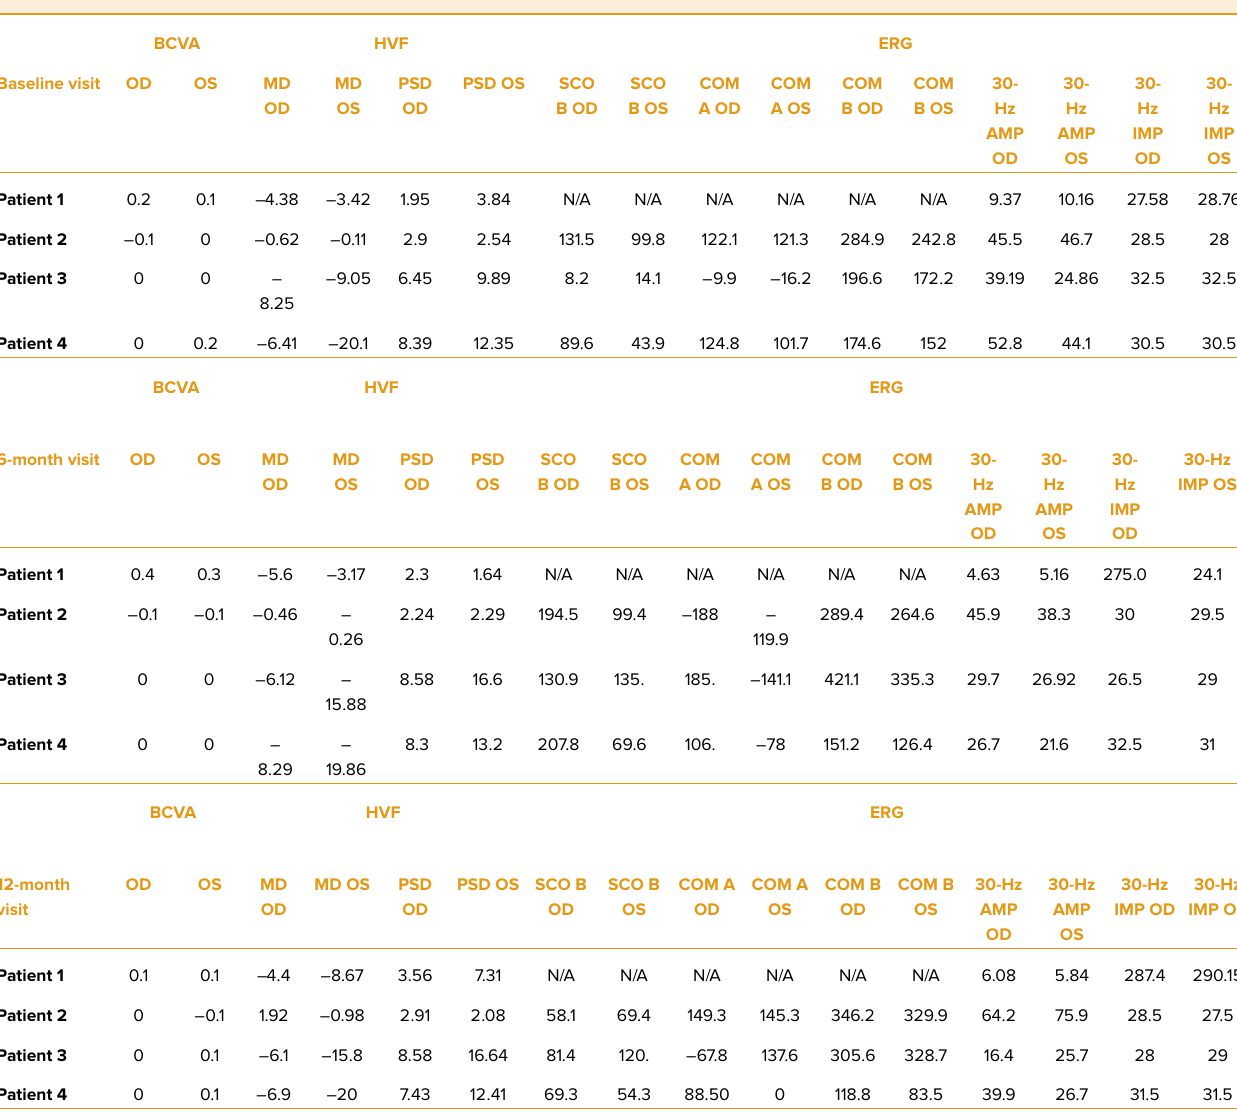
Table 1. Visual function parameters at baseline, 6-month, and 12-month visits in patients on rituximab and bortezomib combination therapy (patient 1–3) and rituximab monotherapy (patient